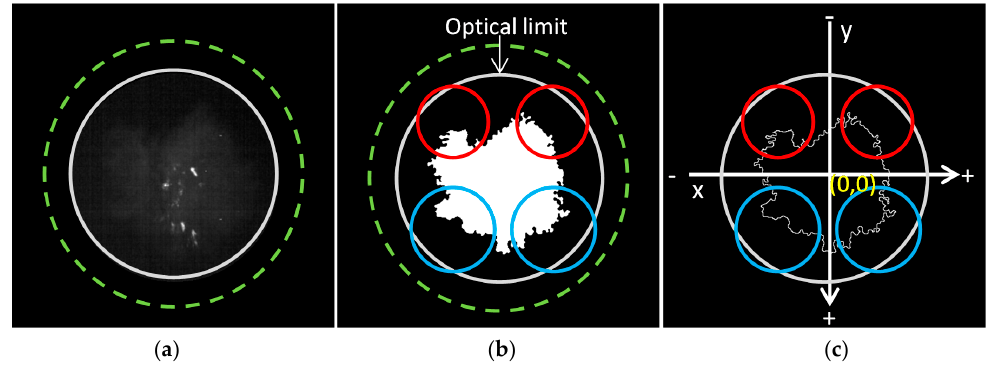
Figure 2. Sketch of the image processing steps for the analysis of the spark ignited flame morphology: ( a ) lookup table (LUT) function application; ( b ) thresholding and FFT filtering; and ( c ) flame contour extraction.